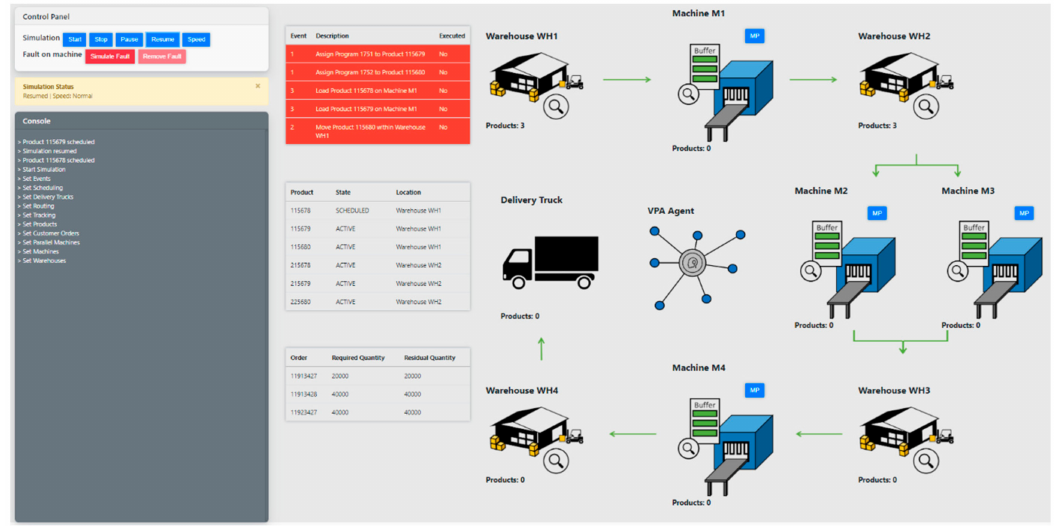
Figure 11. Simulator